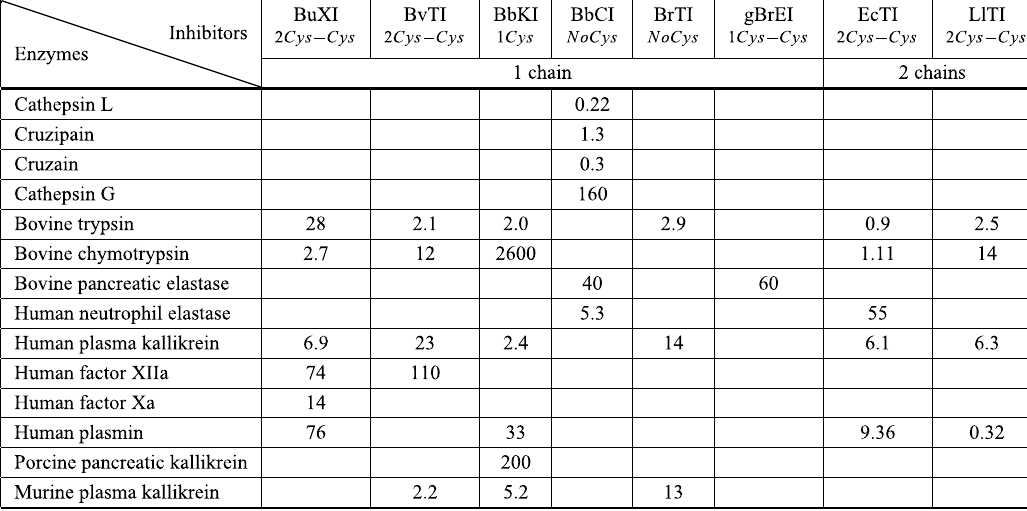
cysteineresiduesformingtwodisulfidebridgesinonepolypeptidechain,Cys 38 -Cys 85 andCys 135 -Cys 144 (SbTInumbering). gBrTI, glycosylated B. rufa trypsin inhibitor has a single disulphide bridge (Cys 41 -Cys 85 ) (Sumikawa et al. 2006); BbKI, B.